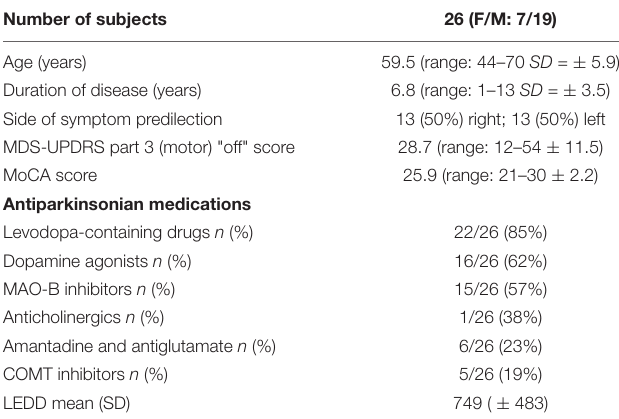
TABLE 1 | Clinical and demographic characteristics of the study